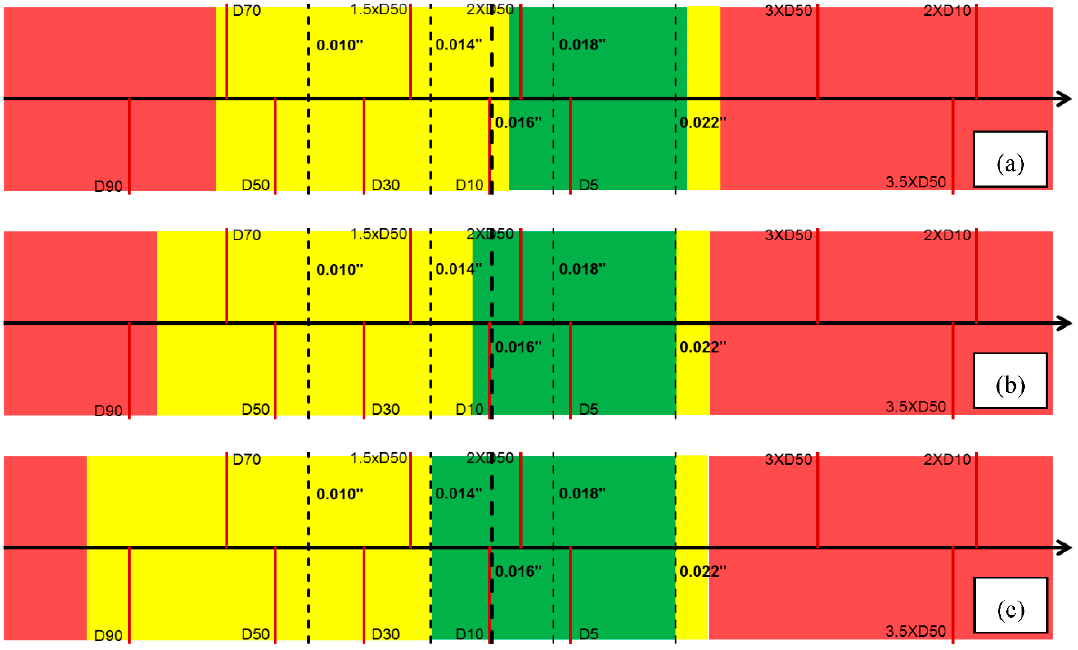
Figure 14. TLS of DC ‐ II in the aggressive condition for SPF 120 ( a ), SPF 168 ( b ), and SPF 216 ( c ).